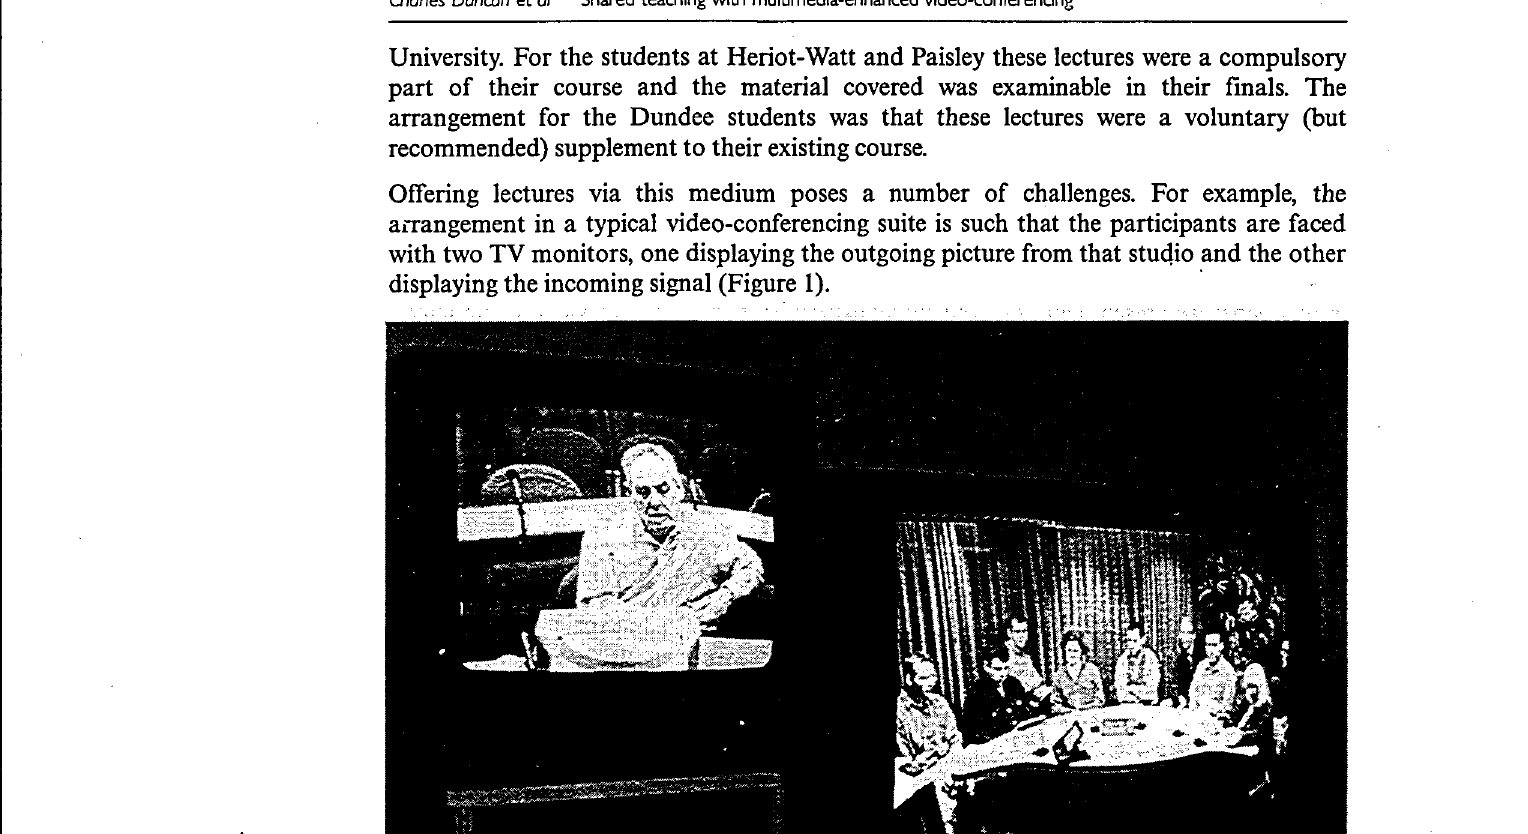
Figure l:Two monitors in the Edinburgh studio showing (¡eft) the outgoing signal and (right) the incoming signal from Dundee since students there had just responded to a